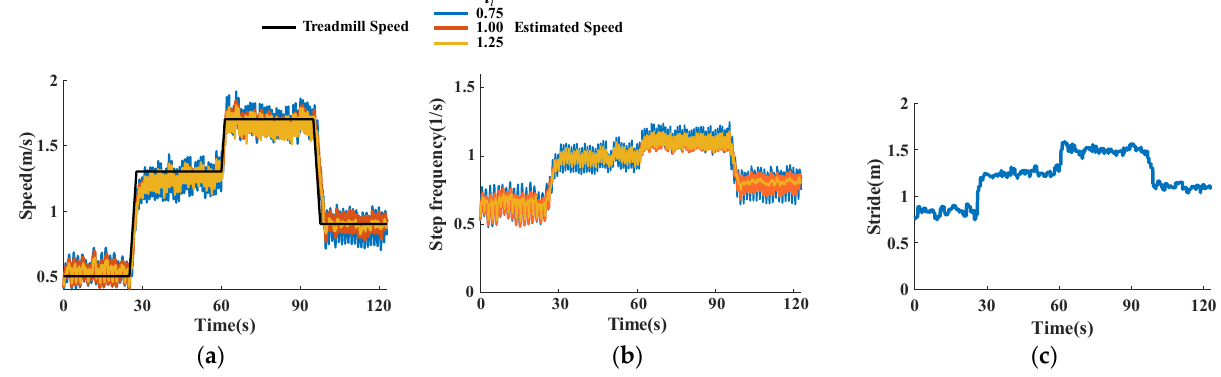
Figure 6. Experimental results based on the AB dataset. ( a ) Speed tracking results. ( b ) Step frequency estimation of AB06. ( c ) Stride estimation of AB06.